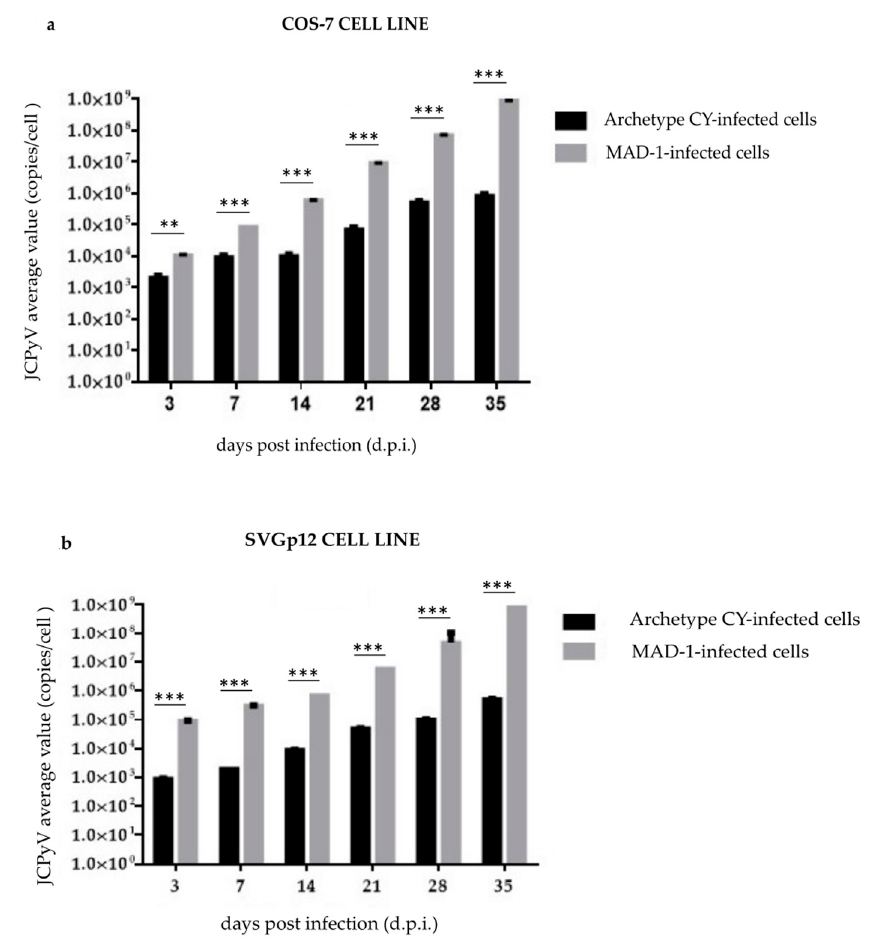
Figure 1. JCPyV replication in the CY- and MAD-1-infected COS-7 and SVGp12 cell lines: ( a ) Archetypal CY and MAD-1 strains compared to address the role of the NCCR in modulating viral replication into the COS-7 cell line at selected sampling times after infection, from 3 d.p.i until 35 d.p.i.; JCPyV DNA was quantified by qPCR. Data are expressed as the mean of three independent experiments, and error bars indicate standard deviations; ns: not significant; ** p < 0.01; *** p < 0.001. JCPyV ‐ loads rapidly increased in MAD ‐ 1 ‐ infected cells, but only slowly in archetypal ‐ CY ‐ infected cultures. ( b ) Archetypal CY and MAD ‐ 1 strains compared to address the role of the NCCR in mod ‐ ulating viral replication into the SVGp12 cell line at selected sampling times after infection, from 3 d.p.i until 35 d.p.i.; JCPyV DNA was quantified by qPCR. Data are expressed as the mean of three independent experiments, and error bars indicate standard deviations. ns: not significant; *** p < 0.001. JCPyV ‐ loads rapidly increased in MAD ‐ 1 ‐ infected SVGp12 cells, but only slowly in arche ‐ typal ‐ CY ‐ infected cultures.